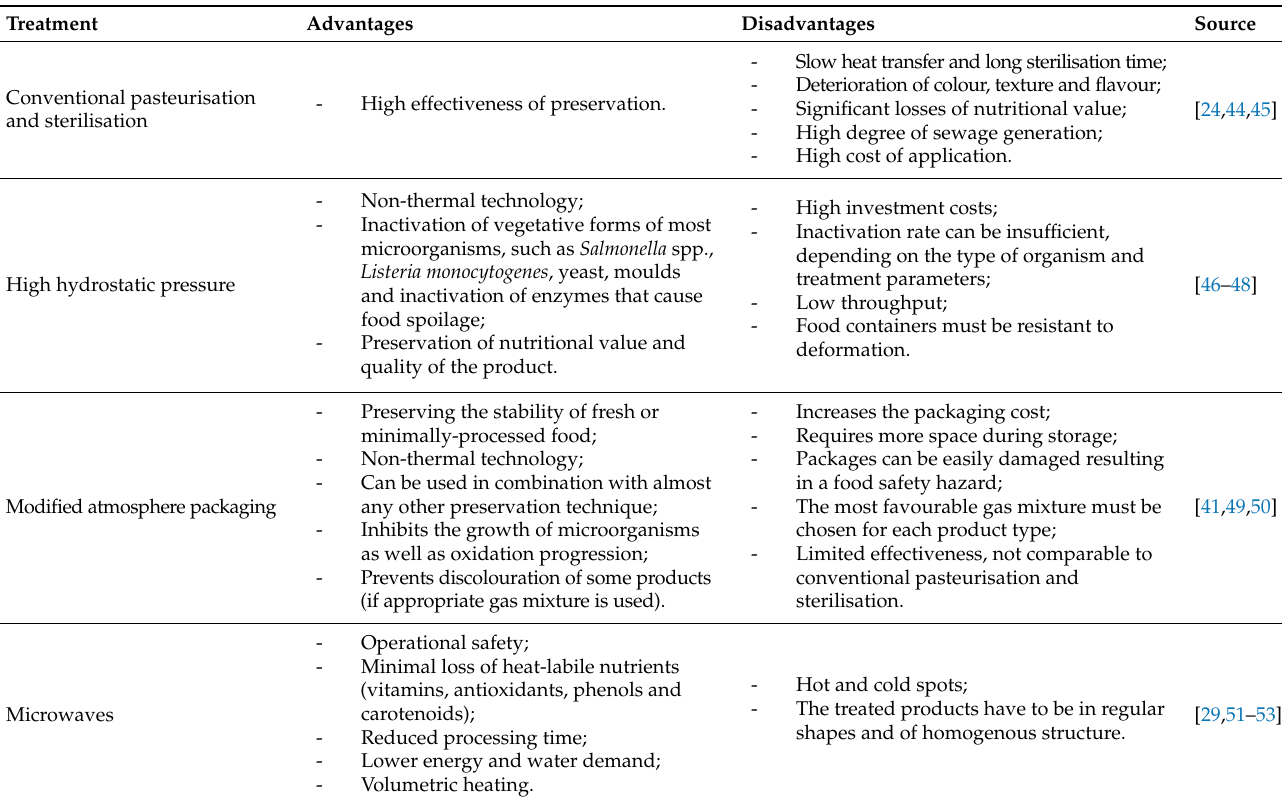
Table 1. Advantages and disadvantages of selected food preservation